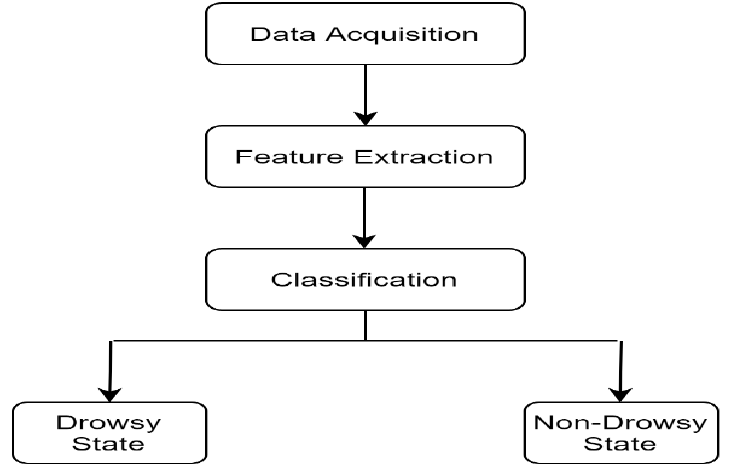
Figure 2. Detection of driver drowsiness using a GSR sensor .